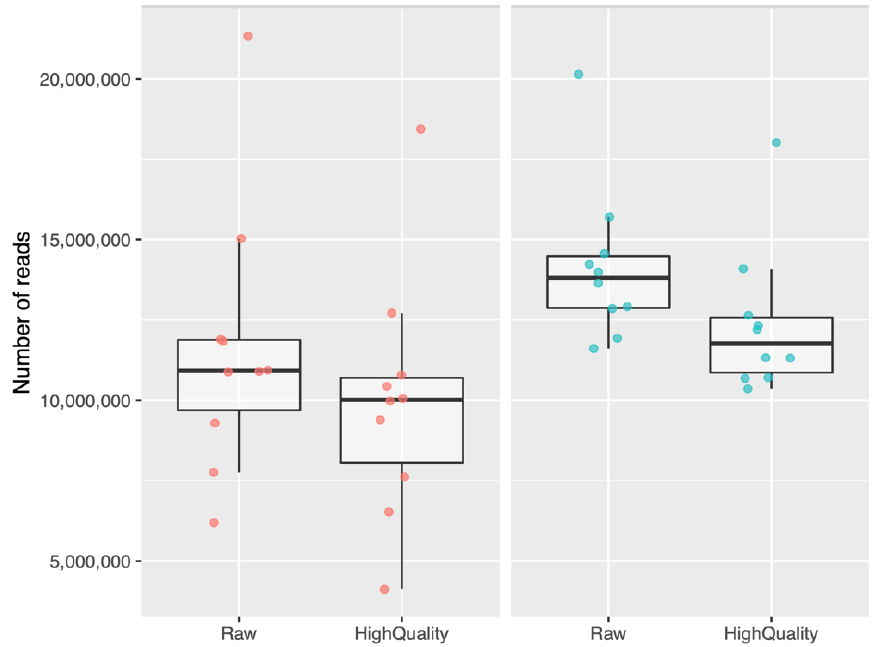
Figure 1. Quantity of sequences obtained in hypercholesterolemic and normocholesterolemic participants. Raw, raw streams in fastp; HighQuality, filtered sequences and high-quality (at least Q30) post-processing with Fastp. Red dots, hypercholesterolemic; blue dots, normocholesterolemic.